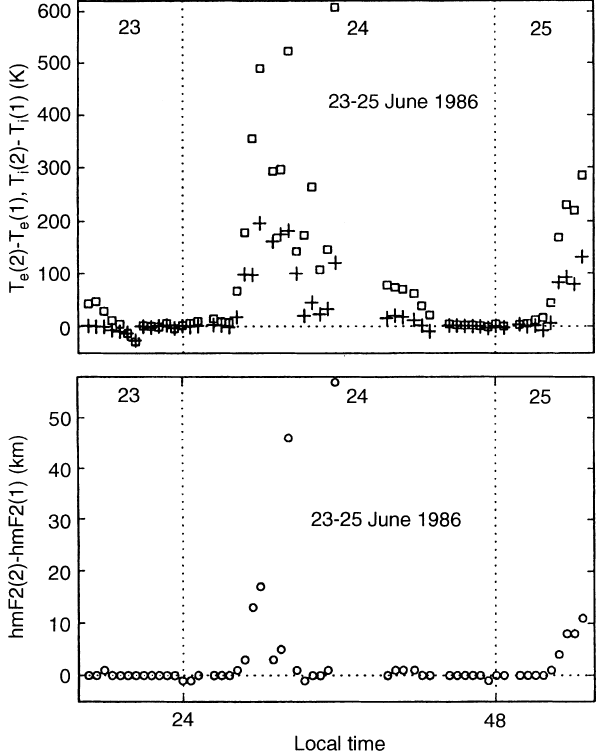
Fig.6. Theerrorsinobserved T e ( squares inthe toppanel )and T i ( crosses in the top panel ), and hmF2 ( bottom panel ) when the Millstone Hill standard ion composition model is used in reduction of the ISR Figure 6 shows the errors T (cid:133) 2 (cid:134) (cid:255) T (cid:133) 1 (cid:134) (squares in e e (cid:133) 2 (cid:134) (cid:255) T (cid:133) 1 (cid:134) (crosses in the top panel) the top panel) and T i i at the F 2 peak altitude, and the errors hmF (cid:133) 2 (cid:134)(cid:255) hmF (cid:133) 1 (cid:134) 2 2 (bottom panel). There are some large di(cid:128)erences in T e